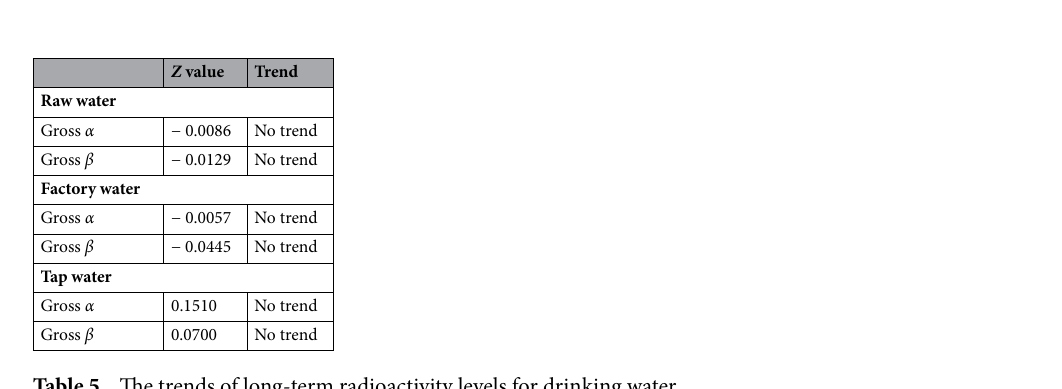
Table 5. The trends of long-term radioactivity levels for drinking